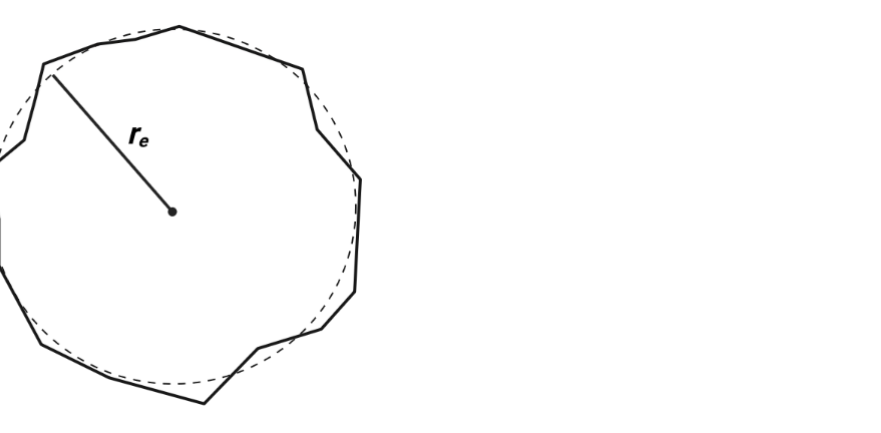
Figure 4. Schematic of the cross section of the tube that displays an irregular pattern. The Length–Radius Relationship in a